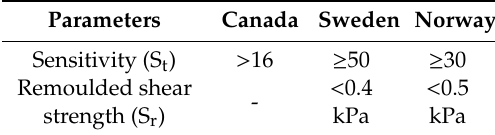
Table 1. Definition of quick clay in three countries.